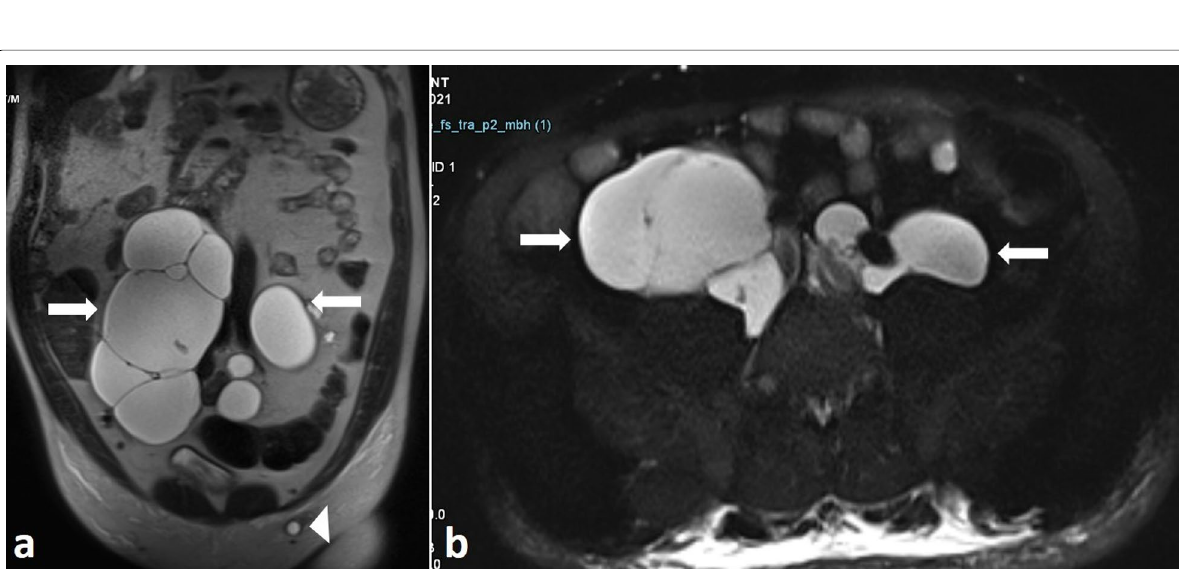
Fig. 2 MRI coronal ( a ) and axial ( b ) T2W images showing cystic masses (white arrows) with thin internal septations. A left inguinal cystic lymph node (arrow